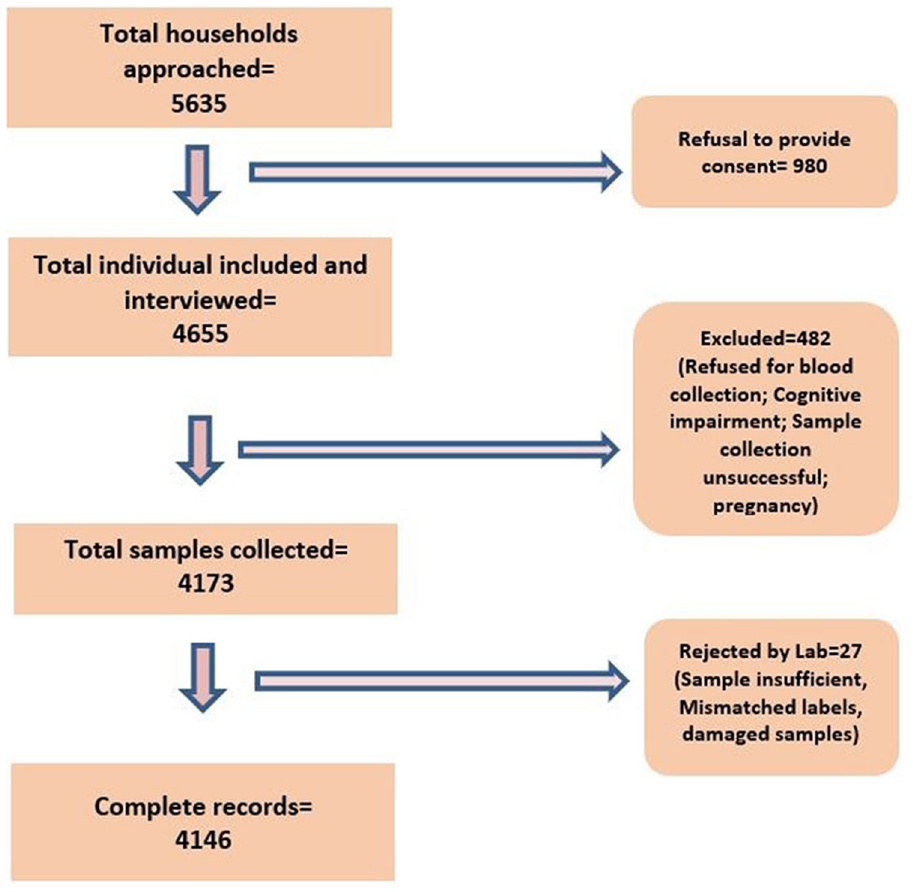
Figure 2. Study Flow diagram of the sample collection